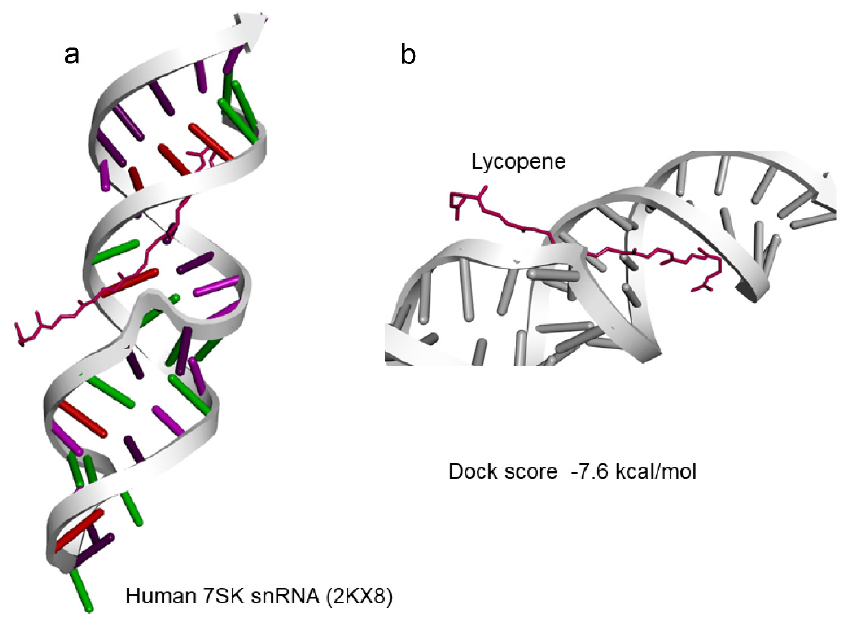
Figure 4. Docking of Lycopene to ( a ) 7SK snRNA (2KX8) and ( b ) with dock score of − 7.6 kcal/mol.